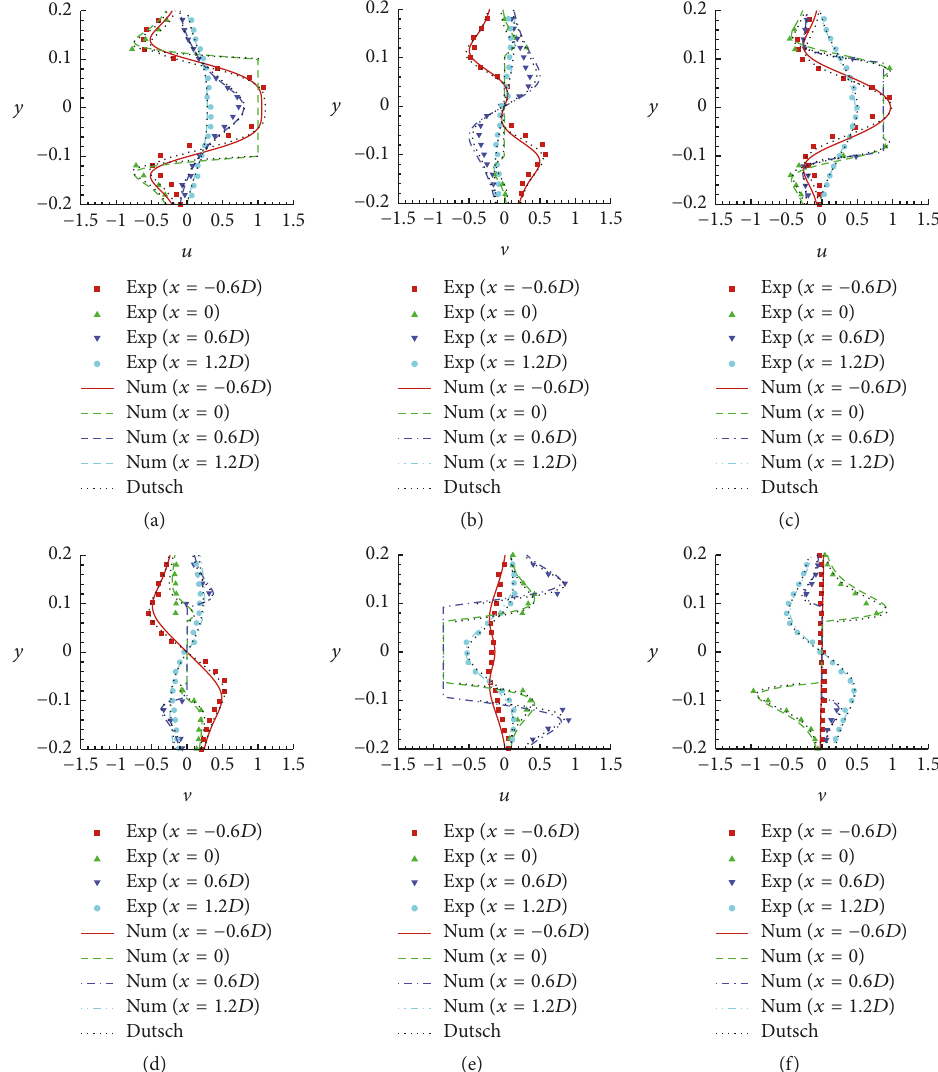
Figure 5: Comparison with results taken of velocity profiles at four cross sections from [13] with constant 𝑥 locations; phase angles: (a-b) 180 ∘ , (c-d) 210 ∘ , and (e-f) 330 ∘